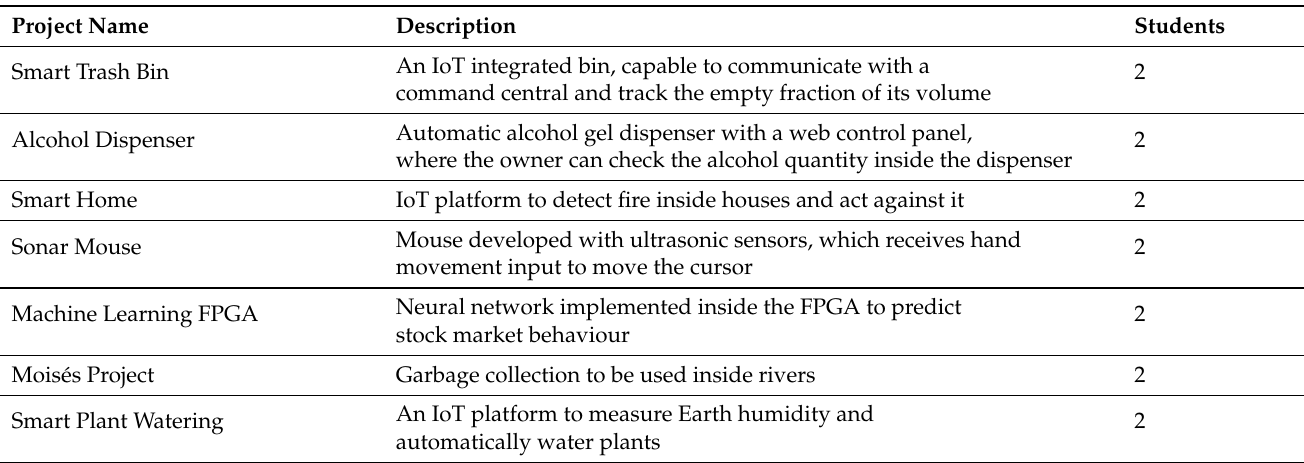
Table 1. Digital Laboratory II